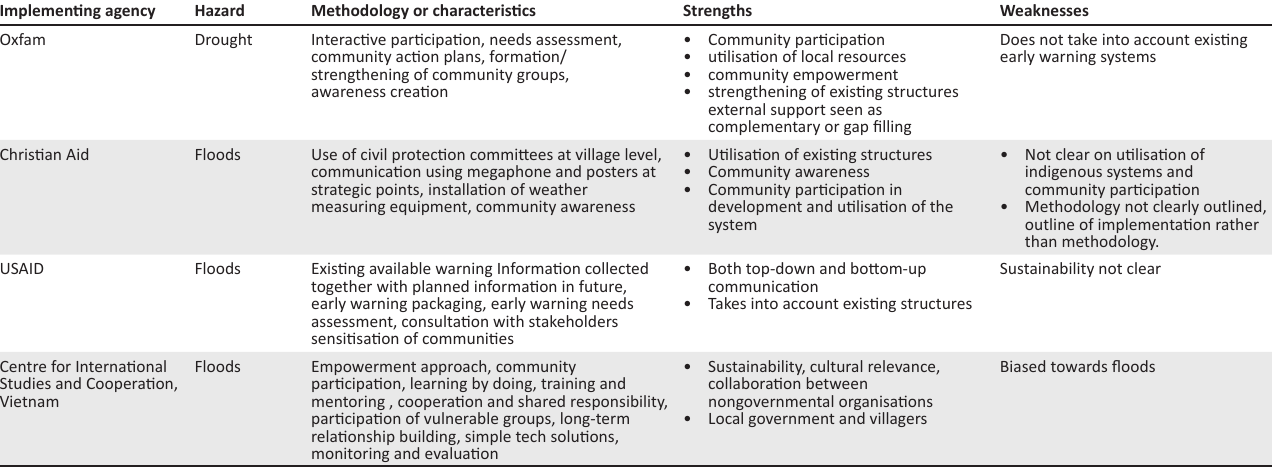
TABLE 2 (Continues...): Methodologies or characteristics of selected community based early warning systems. Implementing